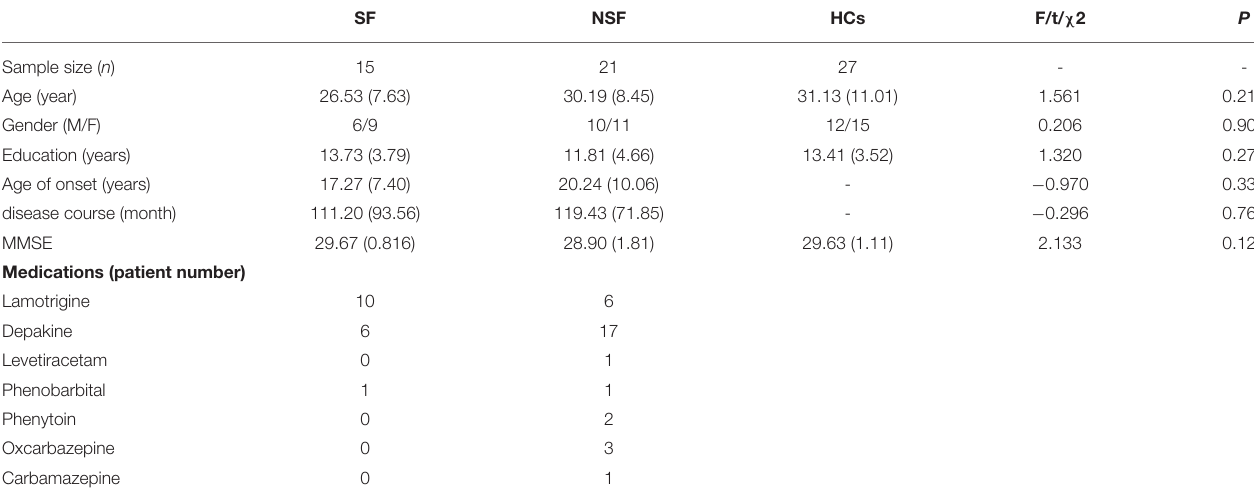
TABLE 1 | Demographic and clinical characteristics of participants. SF